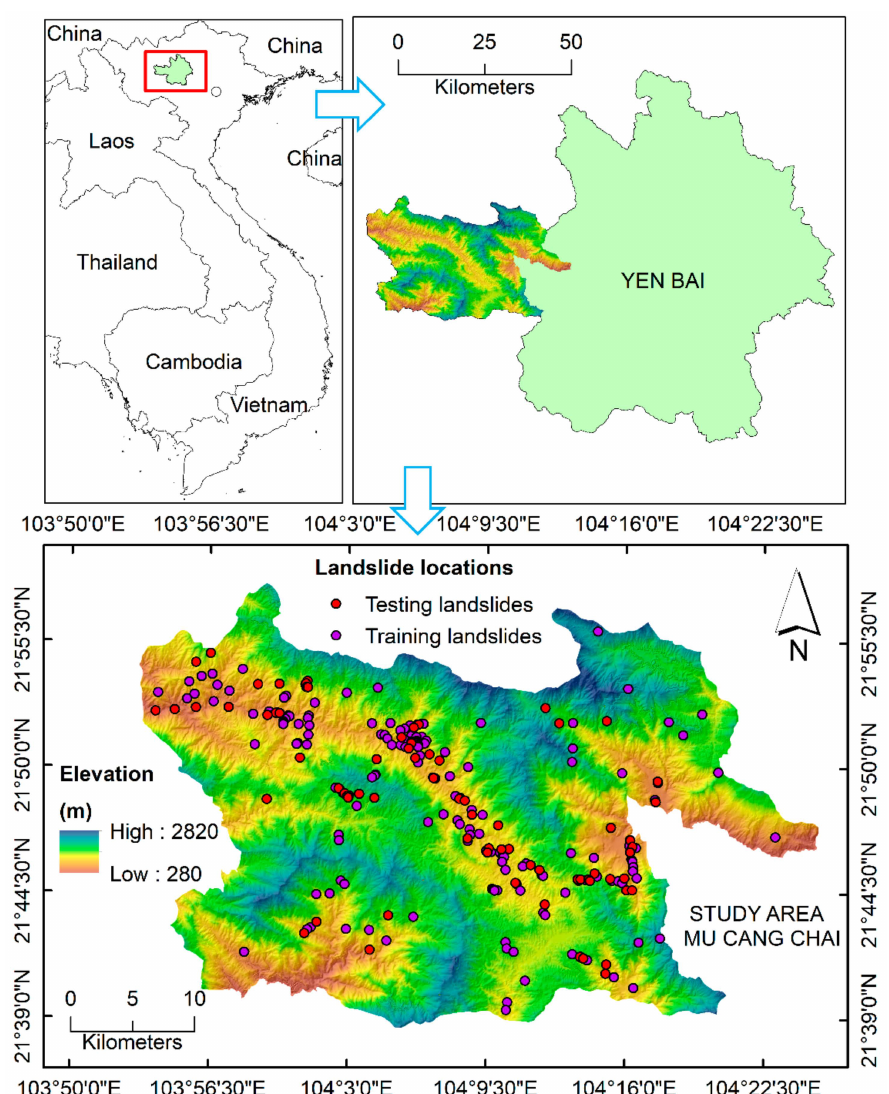
Figure 1. Location of the study area in Yen Bai Province, Vietnam and the landslide inventory